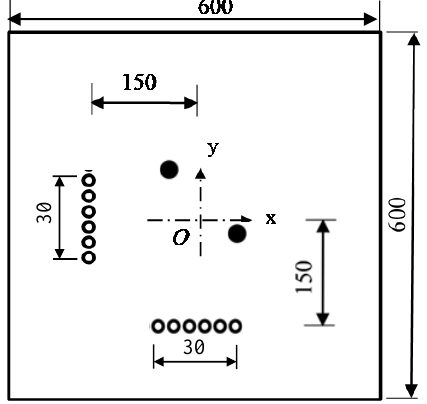
Figure 14. Simulation model containing dual arrays.